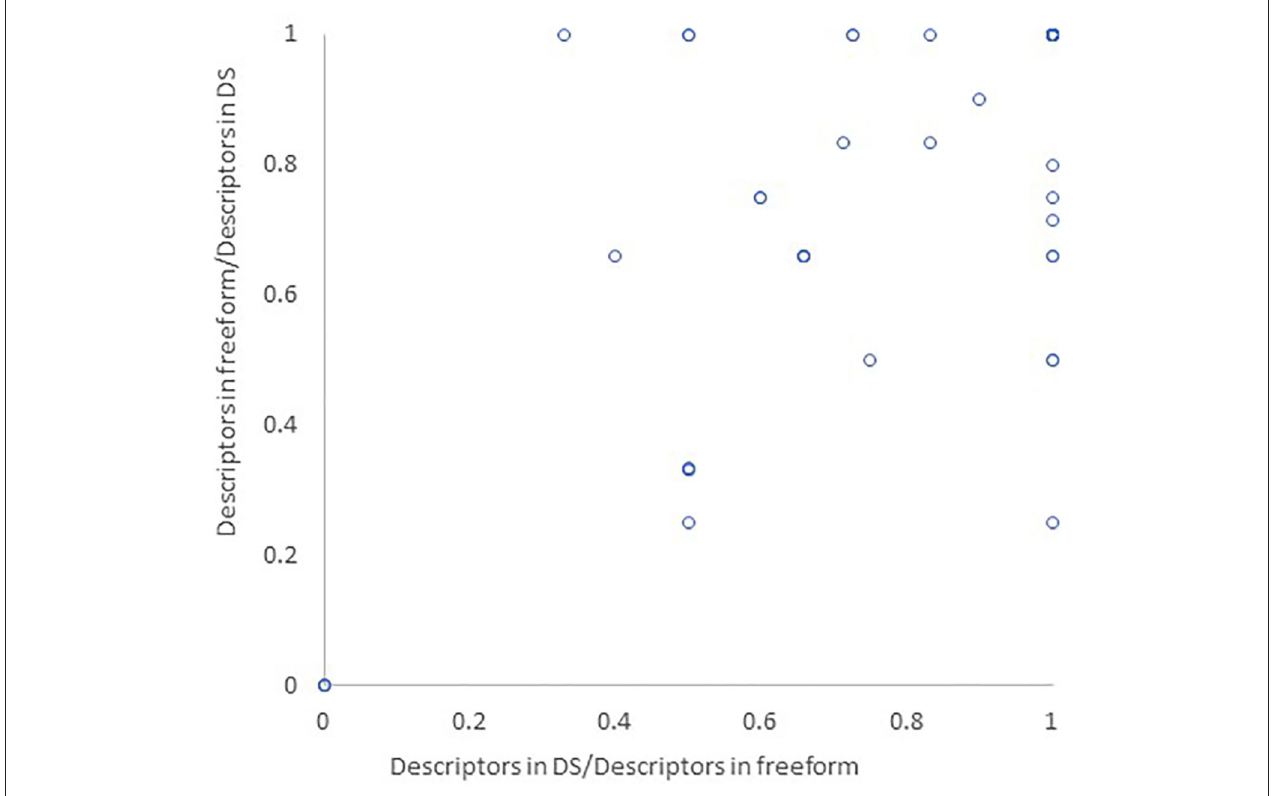
FIGURE 3 | Similarity between DS and freeform reports. The semiologic descriptors appearing in both DS and freeform report were divided by all semiologic descriptors in the freeform report (x axis) and DS report (y axis), corresponding to behaviors omitted from the DS report or added to it,